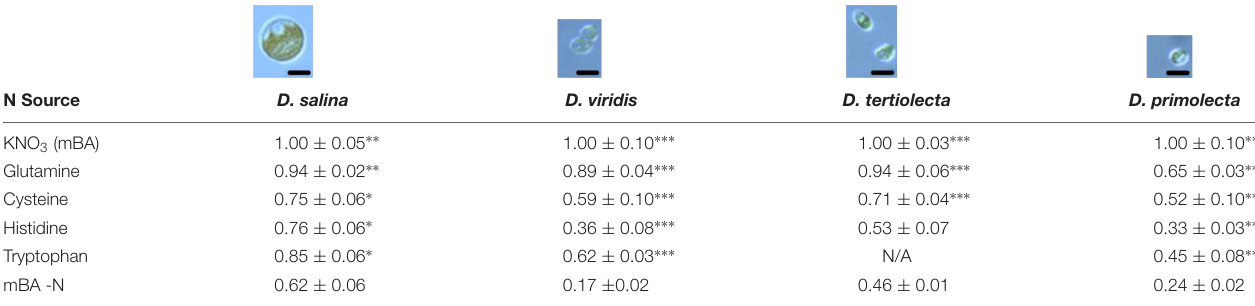
TABLE 2 | Growth of four Dunaliella strains supplemented with Gln, Cys, His, and Trp.